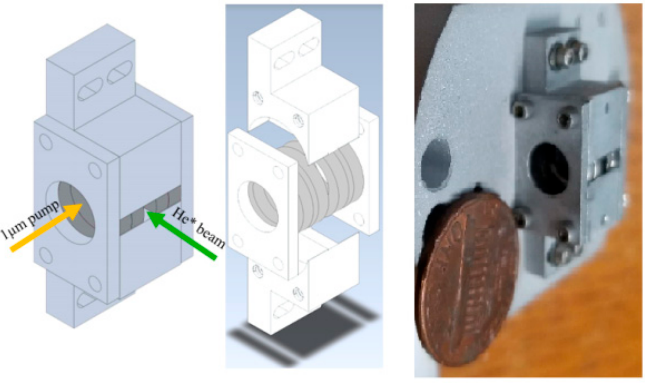
Figure 9. UHV optical pumping magnet mount.